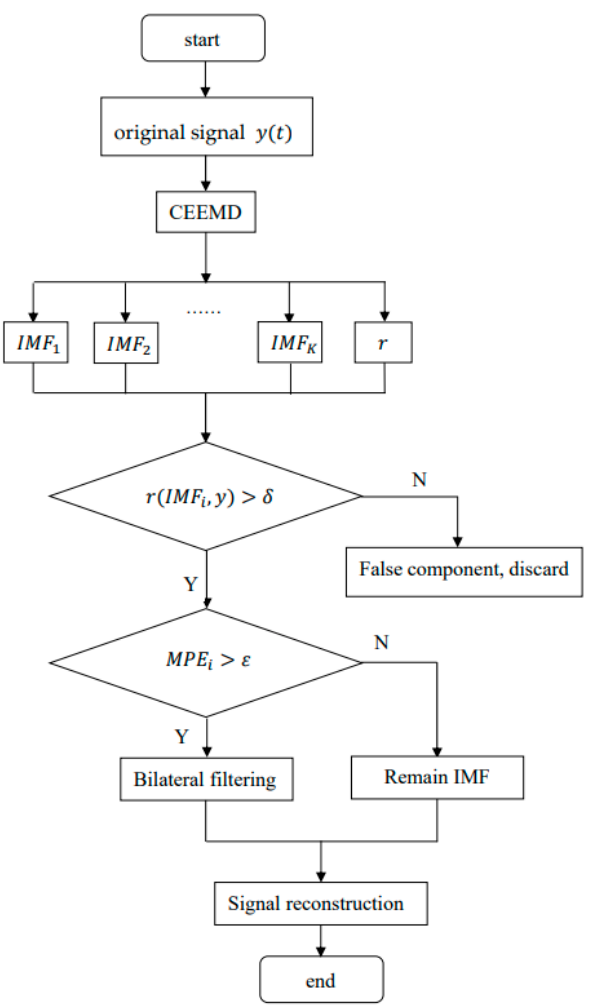
Figure 1. Vibration signal denoising flow chart combining CEEMD and bilateral